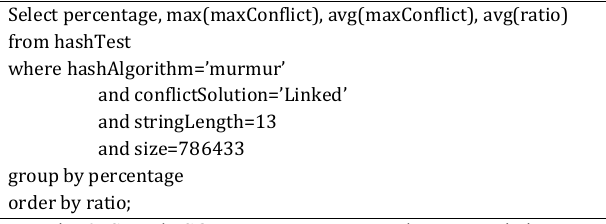
Fig. 3. Sample SQL statements executed to get statistics